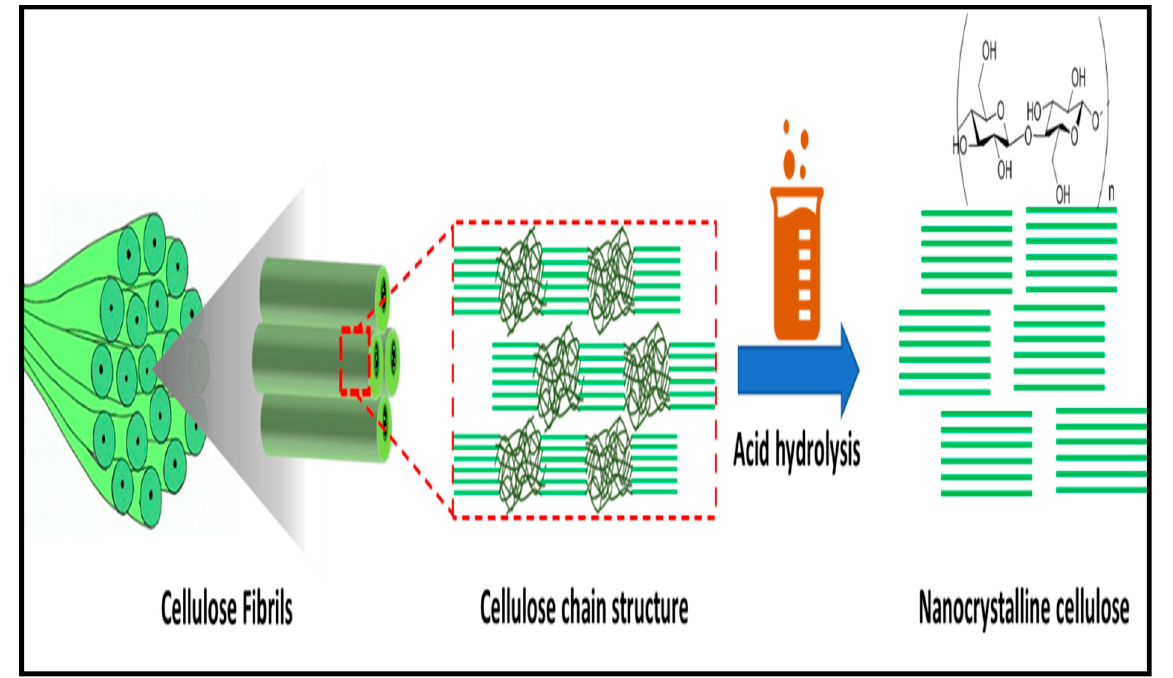
Figure 9. Schematic of nanocrystalline cellulose extraction from cellulose chain using acid hydrolysis for the removal of the amorphous region [115].